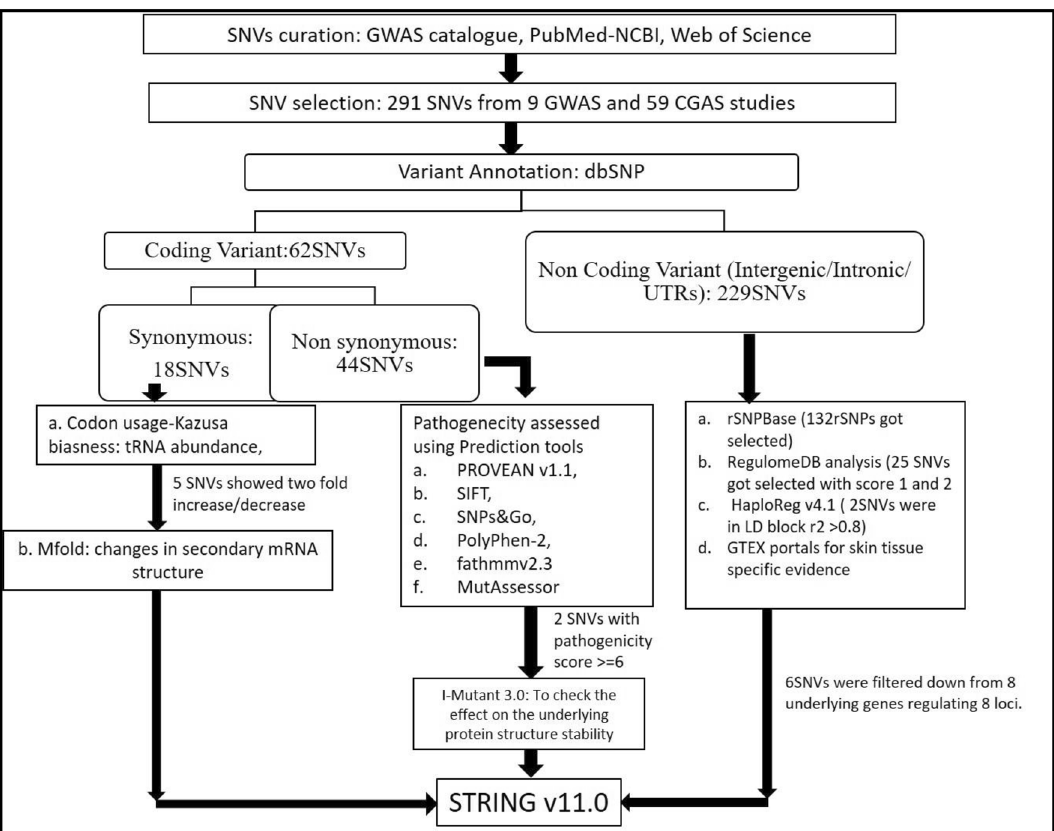
Figure 1. Scheme of the analyses used for prioritization of Vitiligo associated-SNVs. The SNVs and associated information were curated from GWA studies catalog, PubMed and Web of Science. They were categorized into coding and non-coding variants using dbSNP, and the coding variants were further classified into synonymous and non-synonymous. Using different bioinformatics programs the functional potential of each of these SNVs was identified and the SNVs were ranked on that basis. While the synonymous variants were prioritized based on their codon usage biasness and changes in predicted secondary mRNA structure, the non-synonymous variants were prioritized through programs assessing the ability of the variant amino acid to tinker the function of the protein concerned. The non-coding SNVs were assessed for their regulatory potential using several bioinformatics programs. The skin tissue specific regulatory role(s) were assessed through eQTL based evidence from GTEx Portal. Lastly, the genes in which the prioritized SNVs were located or the target genes of the prioritized SNVs were checked for their presence in Harmonizome, GeneMania and KEGG: Kyoto Encyclopedia of Genes and Genomes. Interaction between the proteins coded by the genes that were thus prioritized through the 3 priority pipelines viz. that for non-synonymous, synonymous and regulatory SNVs, was checked by STRING of the codon, specific anti-codon containing tRNAs are more available in living organisms than other codons and any synonymous nucleotide variation in codon sequence, thus, could alter protein synthesis but not the peptide sequence. In this study, a two-fold increase/decrease in tRNA abundance in between wild -type and mutant codon was taken into consideration as a significant change which were then analyzed in the mfold Web Server RNA folding form (http:// unafo ld. rna. albany. edu/?q= mfold/ RNA- Foldi ng- Form). mfold Web Server provides us the predicted secondary mRNA structure based on query FASTA sequence containing wild-type and mutant SNV sequence along with ΔG value for the same representing protein stability. Fol- lowing this, we checked each circular plot (as shown in Supplementary Fig. 1) and noted the change in the circular plot of the RNA secondary structure via the ’RNA Folding Form’ of mfold Web Server. In the "View Individual Structures" section, the RNA Folding Form provides a hierarchical view of the possible stem- looped secondary structures based on delta G values, for all probable stem-looped secondary structures. The syn-SNVs whose circular plots were not different between the different allelic forms for a particular syn-SNV were filtered out. [see S6]. iii. Analysis of non-coding SNVs: For the non-coding SNVs, we wanted to assess their regulatory potential [i.e. ability to regulate tran- scription of the target gene] if any, and thus prioritize them along with their target genes with respect to their contribution towards developing vitiligo. We ran the SNVs through rSNPBase and RegulomeDB and selected the potential regulatory SNVs as predicted by these tools for further analysis.